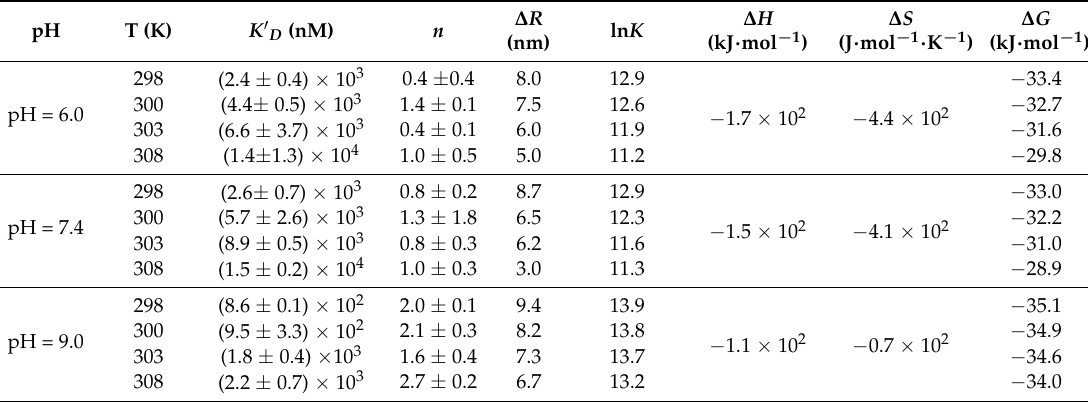
Table 2. Summary of measured K (cid:48) D , ∆ R , ln K , Hill coefficient n , and ∆ H , ∆ S , and ∆ G for BSA and QDs binding at different pH (6.0, 7.4, and